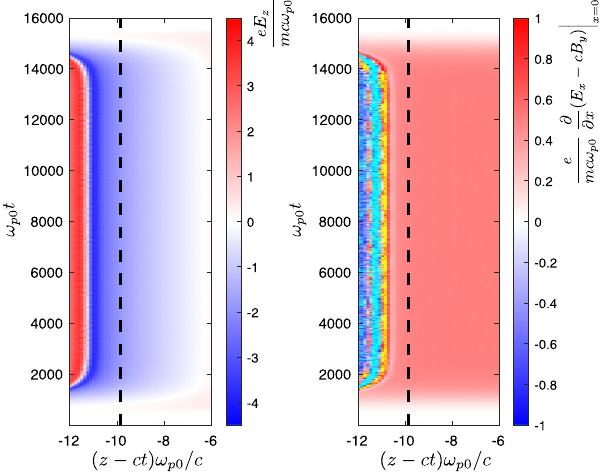
5. (left) The axial accelerating field E and (right) focusing z gradient on an ultrarelativistic particle propagating in the z ∂ ð E − cB = ∂ x j direction, ð e=mc ω both extracted as a p 0 Þ x y Þ x ¼ 0 lineout in the z direction along the axis and plotted as a time series. The black dashed line indicates the wake phase chosen for the beam given initial energy γ 0 . Figure 6 shows a representative trajectory through the fields. The red and black lines show repeated application of M n ð γ n Þ to initial extended coor- dinates w δ 0 , for either δγ ¼ 0 or δγ ¼ 1950 for an initial beam energy γ ¼ 19 500 , i.e., δγ = γ ¼ 0 . 1 . The blue curve shows the particle energy as a function of propagation time, up to γ ¼ 42 891 , i.e., just over 10 GeV acceleration in the stage. Although it is obvious has to be the case, we also